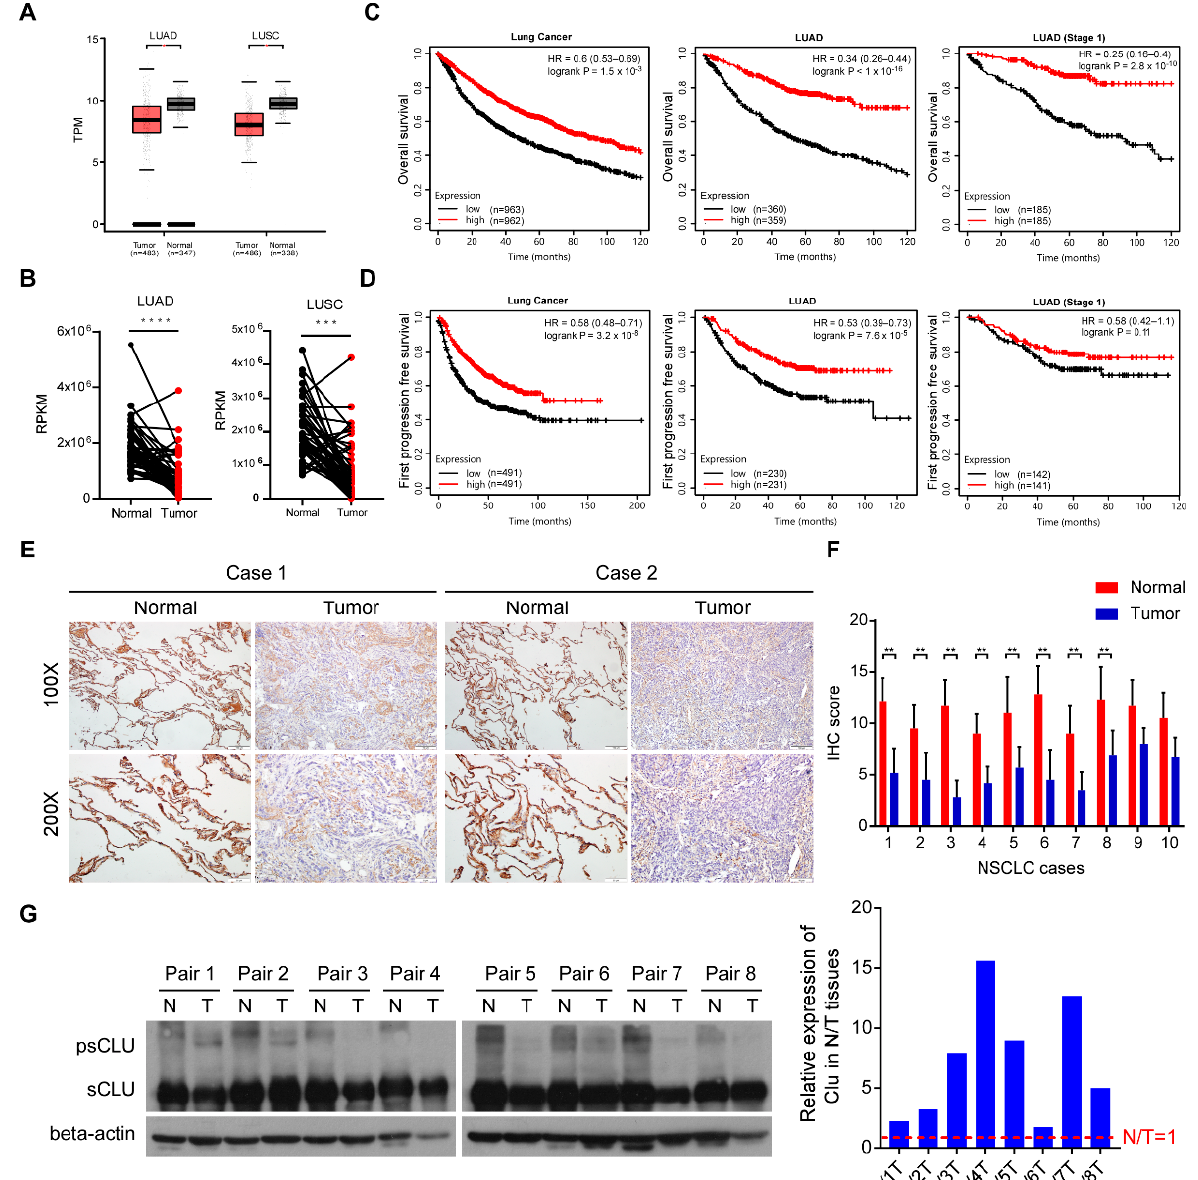
Figure 1. CLU downregulation in lung cancer correlates with poor patient survival. ( A ) The expres- sion of CLU in GEPIA (Gene Expression Profiling Interactive Analysis) datasets. ( B ) The expression of CLU in 34 pairs of LUAD tumor tissues and 49 LUSC tumor tissues versus matched non-tumorous lung tissues in the K − M plot lung cancer database. ( C ) Kaplan-Meier analysis of overall survival in TCGA lung cancer, LUAD and LUAD (stage 1) cohort based on the expression of CLU. ( D ) Kaplan-Meier analysis of first progression-free survival in TCGA lung cancer, LUAD and LUAD (stage 1) cohort based on the expression of CLU. The divergence of patient survival between CLU high- and low-expression patients was statistically significant within the above cancer types. ( E ) Typical photographs of IHC staining on CLU expression in the lung cancer and adjacent normal tissues. ( F ) IHC score of CLU expression in lung cancer and paired adjacent normal tissues (n = 10). ( G ) CLU protein levels in 8 pairs of lung cancer and adjacent normal tissue proteins, and β -actin was used as a loading control. The band at 68 kDa indicated the presence of precursor CLU (psCLU) and the band at 37 kDa indicated the presence of secretory CLU (sCLU). Results are presented as mean ± SD, ** p < 0.01, *** p < 0.001 , **** p < 0.0001 .